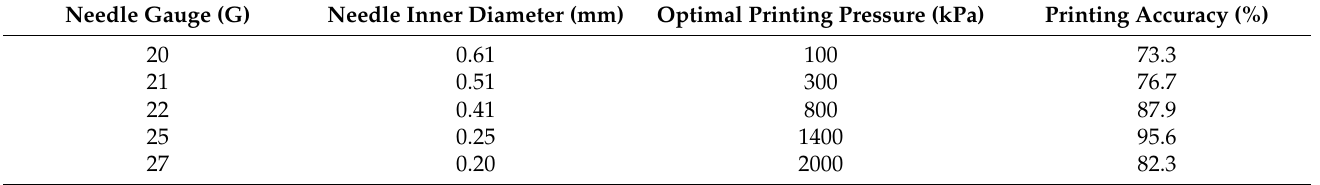
Table 2. Assessment of 3D printing needle size and printing accuracy (%) of